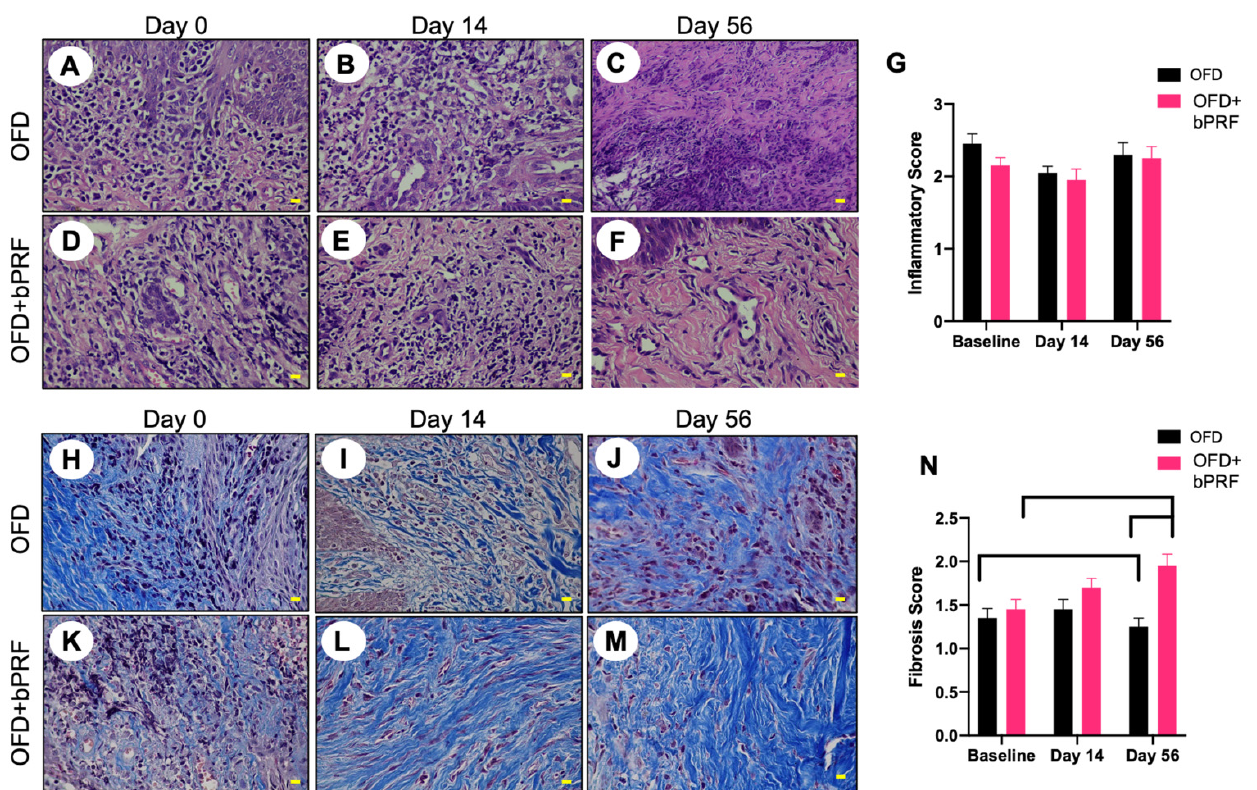
Figure 4. Bubaline blood-derived platelet-rich fibrin (bPRF) enhanced extracellular matrix production. Gingival tissues were collected from the buccal area of the tooth at days 0, 14, and 56 after intervention. Representative images of hematoxylin and eosin-stained ( A – F ) and Masson’s trichrome-stained ( H – M ) sections were demonstrated. Inflammatory and fibrosis scores were illustrated (( G , N ), respectively). OFD; open-flap debridement-treated group, OFD+bPRF; open-flap debridement and bubaline blood-derived platelet-rich fibrin-treated group. Yellow scale bars indicate 10 µ m. Bars indicate a statistically significant difference.